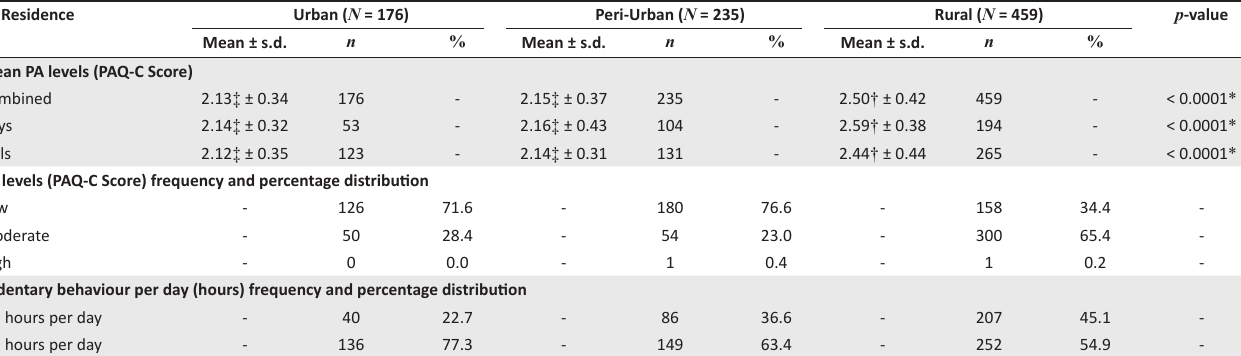
TABLE 1c: Summary levels, frequencies and percentages of physical activity (PA) and sedentary behaviour classifications by residence. By Residence Urban ( N =